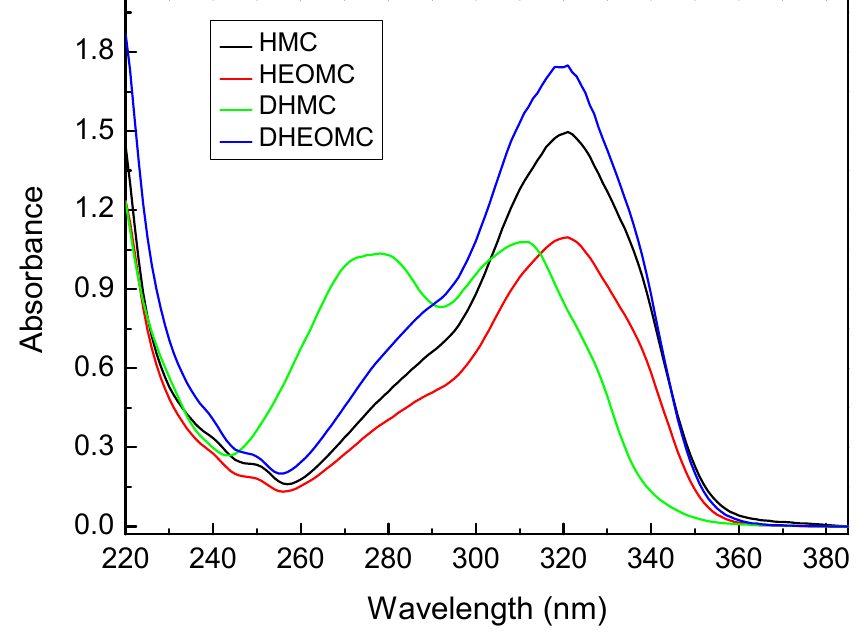
Figure 2 . Absorption spectra of the coumarin compounds. Figure 2. Absorption spectra of the coumarin